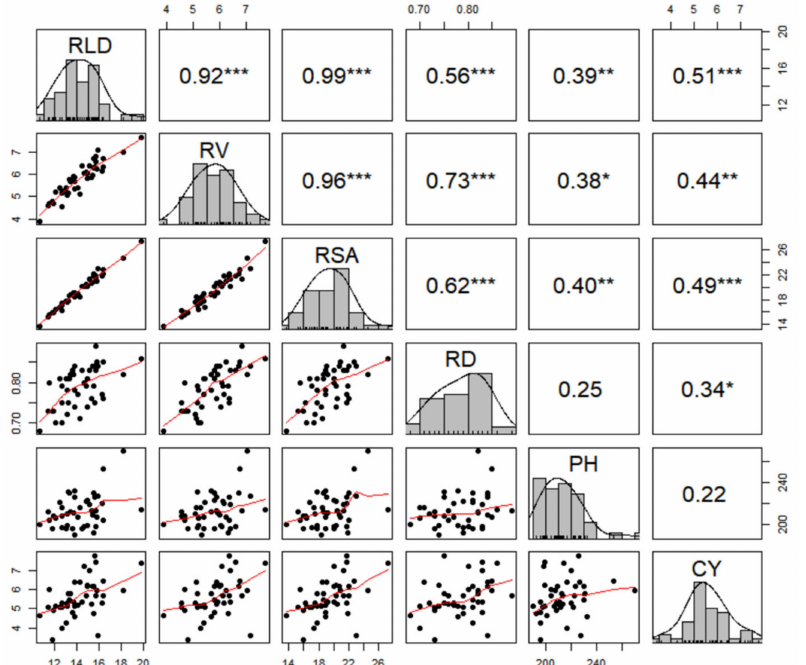
Figure 4. Correlation root length density, root volume, root superficial area, root diameter, plant height, and crop yield from 43 C. canephora . * Significant at p < 0.1, ** significant at p < 0.05, *** significant at p < 0.01. The red lines indicate the trend lines between variables. RLD: root length density, RV: root volume, RSA root superficial area, RD: root diameter, PH: plant height, CY: crop